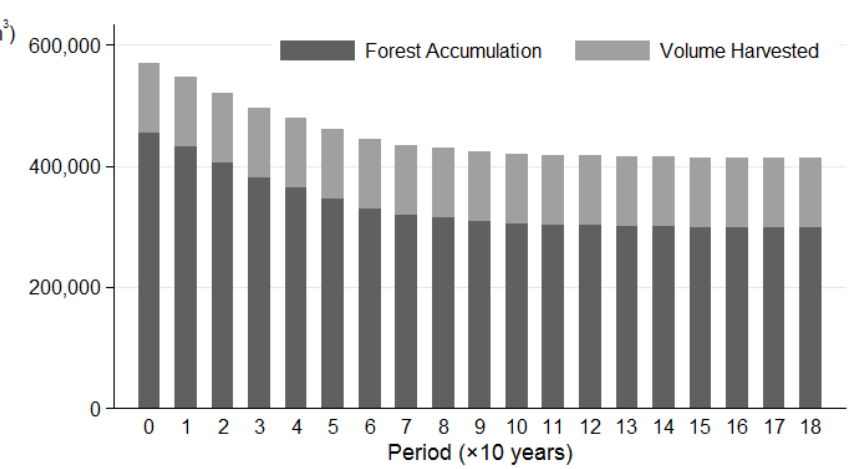
Figure 3. Changes in forest accumulation and volume harvested.